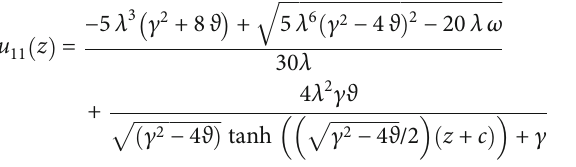
p ffiffiffiffiffiffiffiffiffiffiffiffiffiffi γ 2 − 4 ϑ